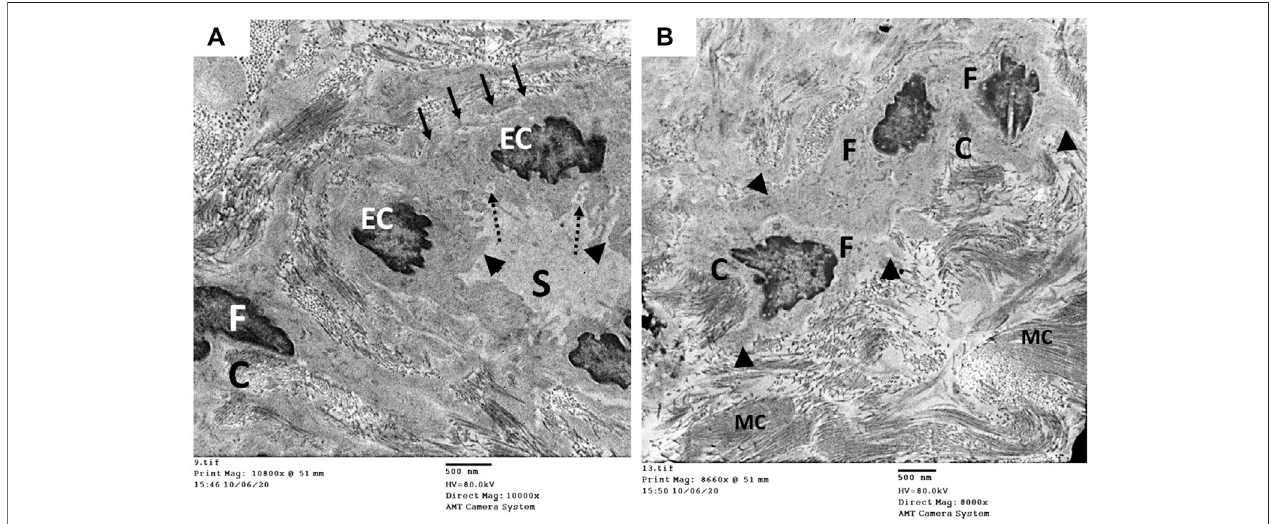
FIGURE 11 | Transmission electron microscopic pictures of the corpus cavernosum (CC) of diabetic rat (group II) showing (A) narrow cavernous spaces (S) lined with a single layer of endothelial cells (EC) showing villi-like projection (arrowhead) into the cavernous lumen, thickened-splitted basal lamina (arrow), and many pinocytic vesicles (dashed arrow) in their cytoplasm. (B) The stroma of the CC showing many active fi broblasts (F) with many cytoplasmic processes (arrowhead) and surrounded by immature collagen fi bers (C), and bundles of mature collagen fi bers (MC) are seen at the periphery of the fi eld.